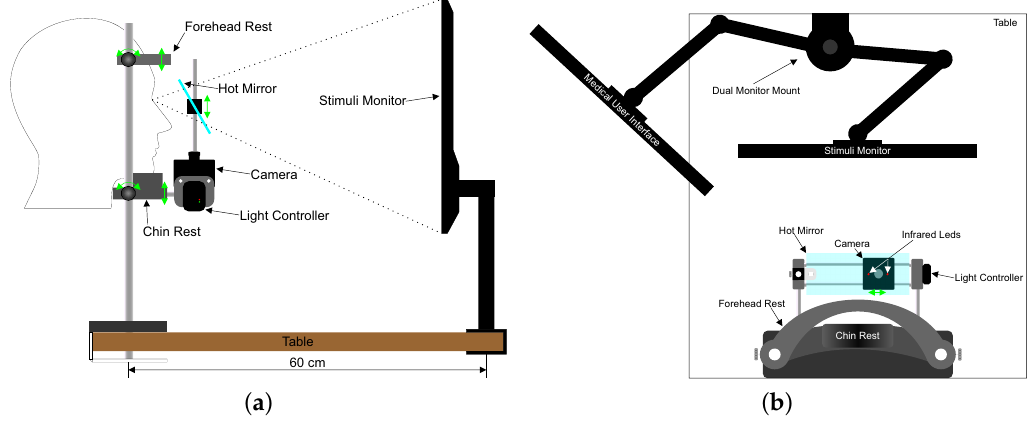
Figure 2. OSCANN Desk 100. ( a ) Side View; ( b ) Top